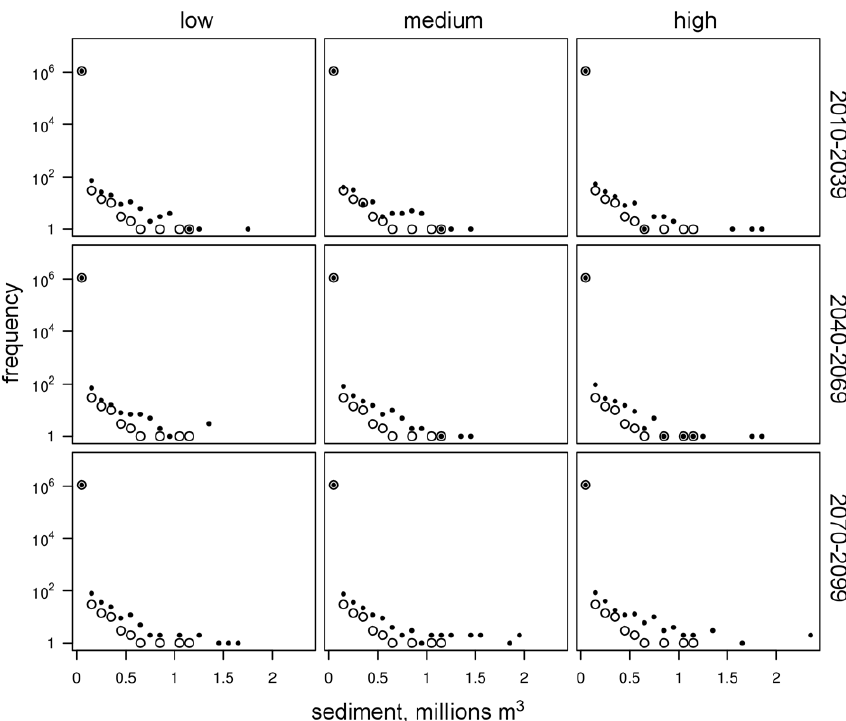
Fig. 5. Frequency plots of daily sediment totals from all nine climate change scenarios (in black), shown against results for the baseline climate, 1961–1990 (in grey). Bin sizes are 100000.